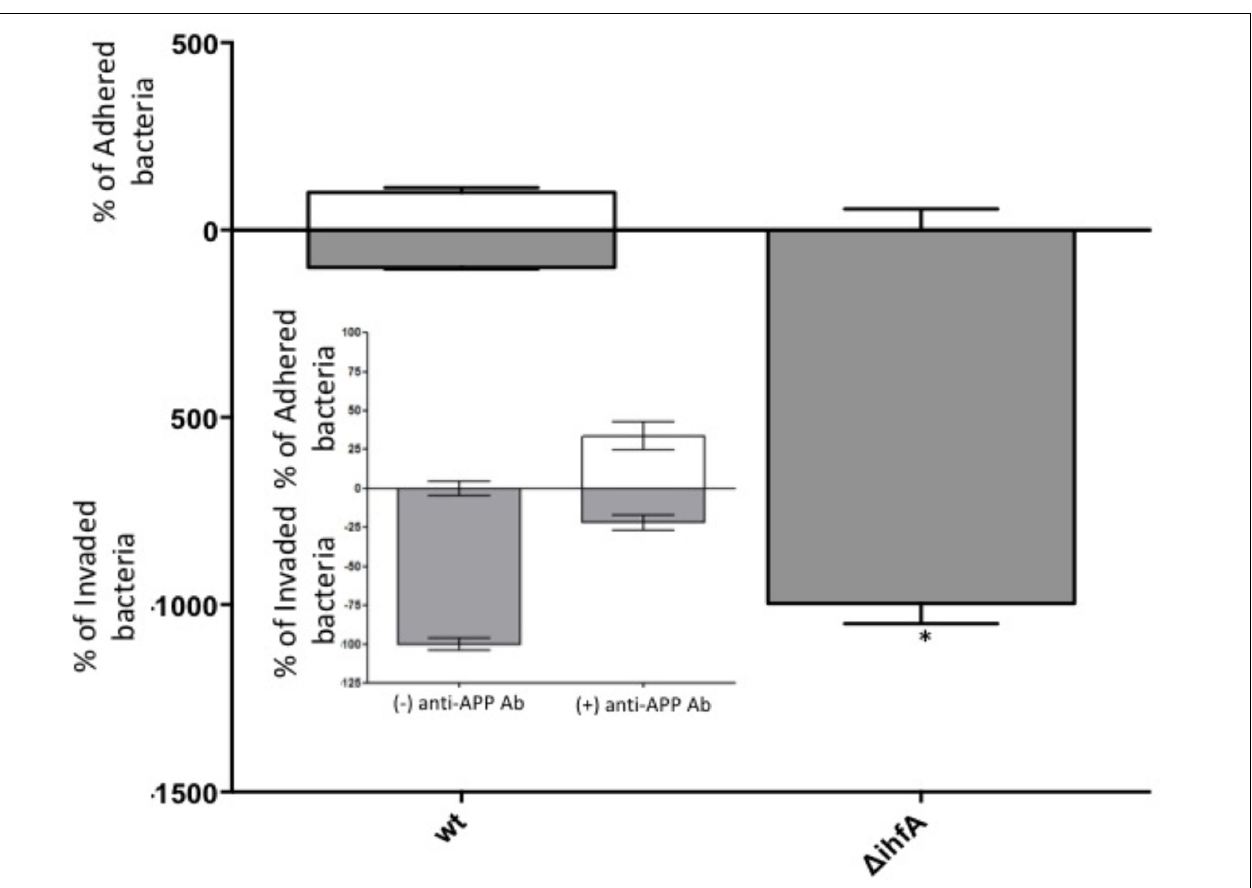
FIGURE 2 | Host association with STM14_5216 mutant and anti-APP antibody blocking. The amount of adhered (white box) and invaded (gray box) S. Typhimurium and the integration host factor α ( ihfA ) deletion mutant with Caco-2 cells. The mean of tree biological replicates with error bars representing the SEM is shown. Significance is assigned as p < 0.05 and indicated with “ ∗